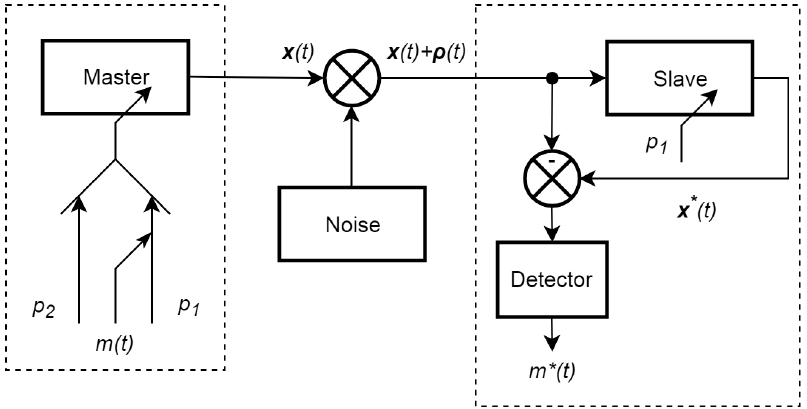
Figure 1. Block diagram of communication system based on Rössler oscillator with parameters modulation.